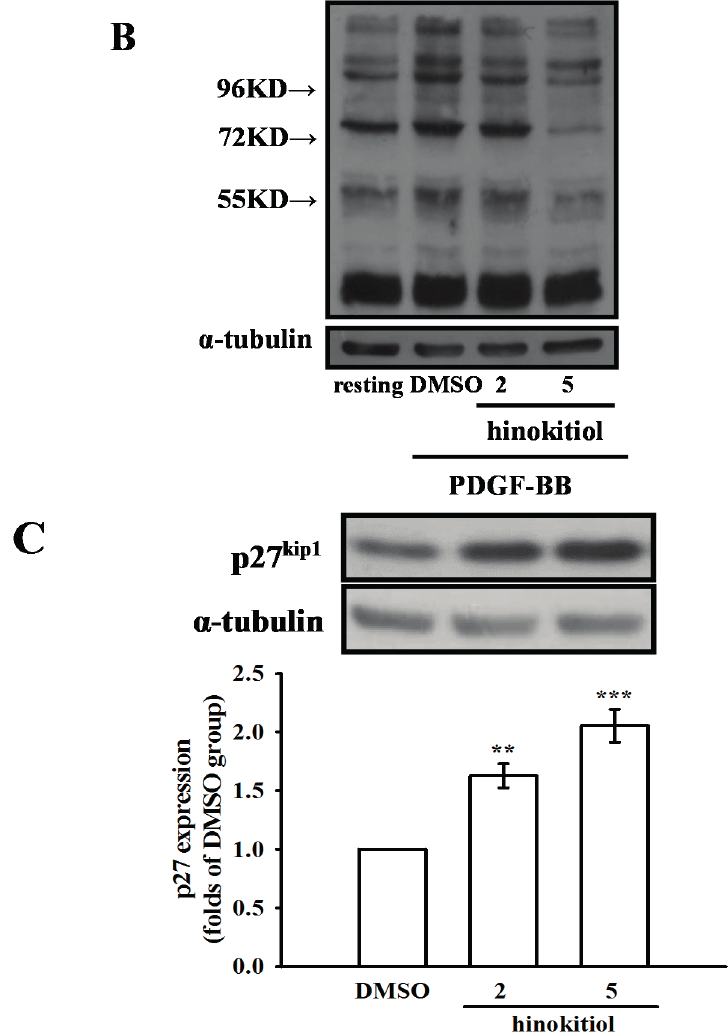
Figure 5. Effect of hinokitiol on PDGF-BB induced p-PLC γ 1 and the expression of p27 kip1 in VSMCs. ( A , B ) Confluent cells were pre-treated in the presence or absence of hiokitiol (2–5 μ M) in a serum-free medium, and then stimulated with 10 ng/mL PDGF-BB at 37 °C for 10 min; ( C ) VSMCs which were cultured under normal condition were treated by hinokitiol (2–5 μ M) for 24 h. The cells were lysed, and the level of p-PLC γ 1, p-Ser/Thr substrates and p27 kip1 were analyzed by SDS-PAGE and immunoblotting. The respective total protein was used for the normalization of phosphorylated ones. Data are expressed as a mean ± S.E.M. (A and C, n = 3; B, n = 4) ** p < 0.01 and *** p < 0.001 compared to the normal cells, # p < 0.05 compared to the PDGF-BB stimulated